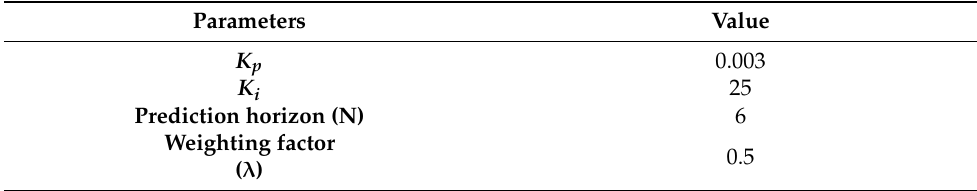
Table 2. Parameters of the controllers.